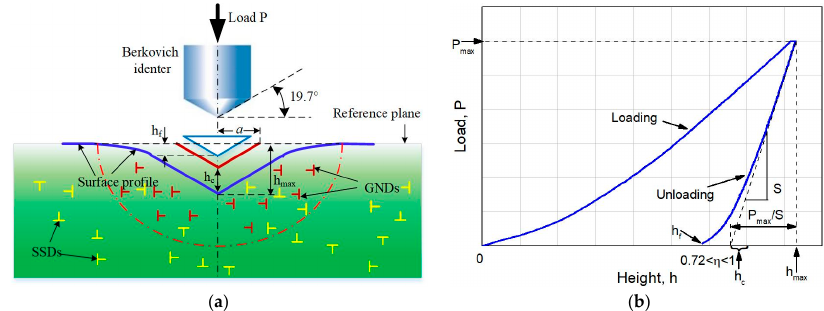
Figure 6. A schematic representation of nanoindentation tests: ( a ) a section through an indentation showing various parameters used for analysis; ( b ) relationship between load and indentation height.